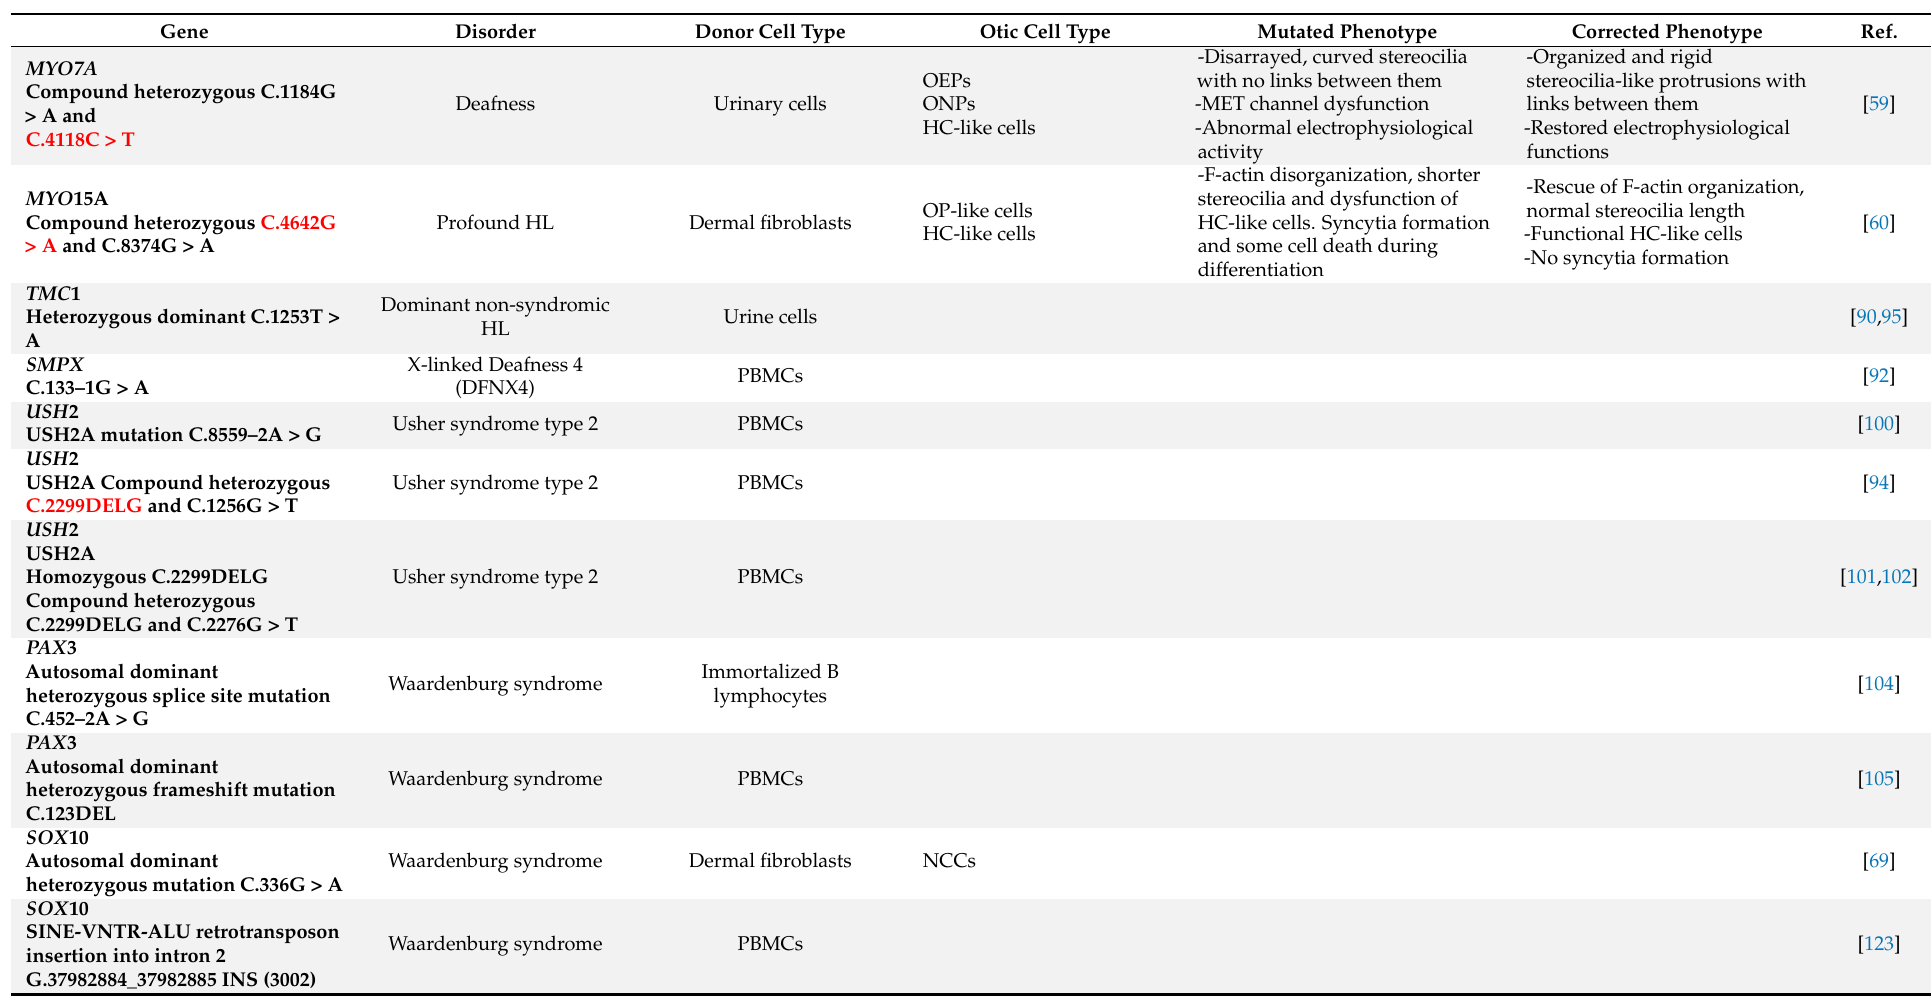
Table 2. List of hiPSC lines that have been generated from hearing-impaired